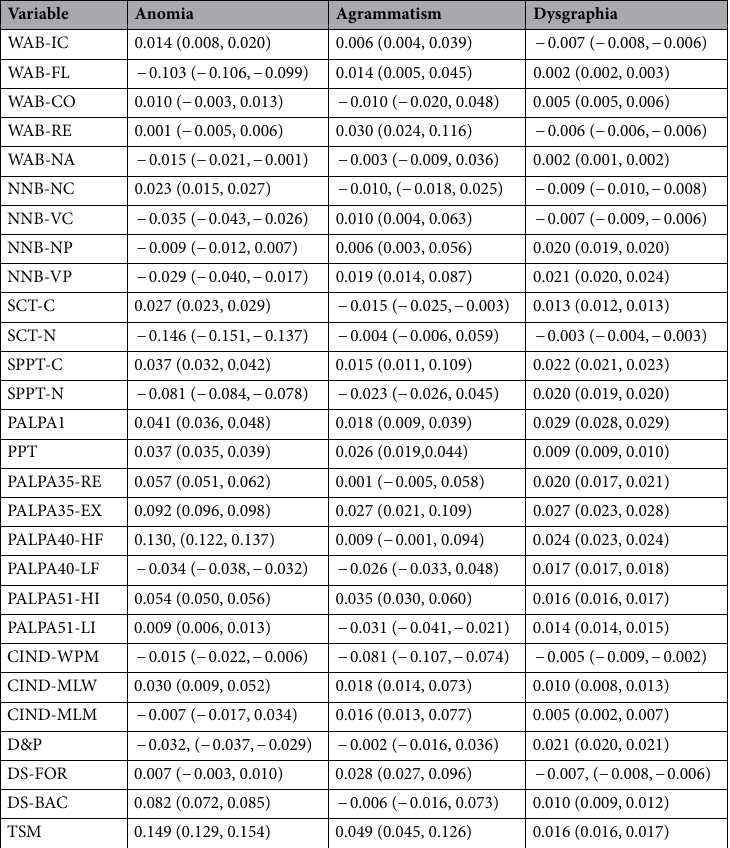
Table 3. Coefficients for models using language and cognitive assessments. The median model coefficient for each behavioral model is shown, followed by the range of minimum and maximum coefficients across 1000 data